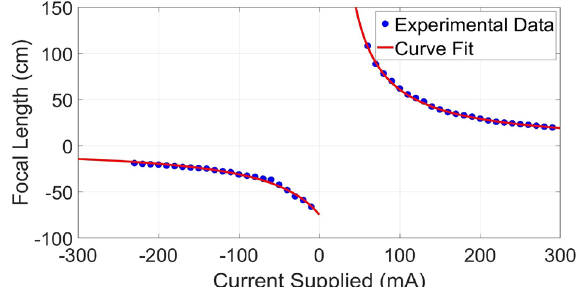
Figure 6. The Optotune EL-16-40 TFL focal length as a function of the applied current as characterized in the lab and approximated by best fit focal length as a function of the applied current I DC to the